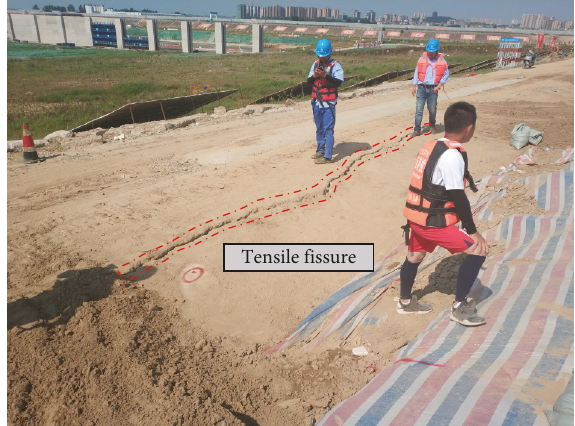
Figure 4: Tensile fissure at the top of upstream cofferdam.